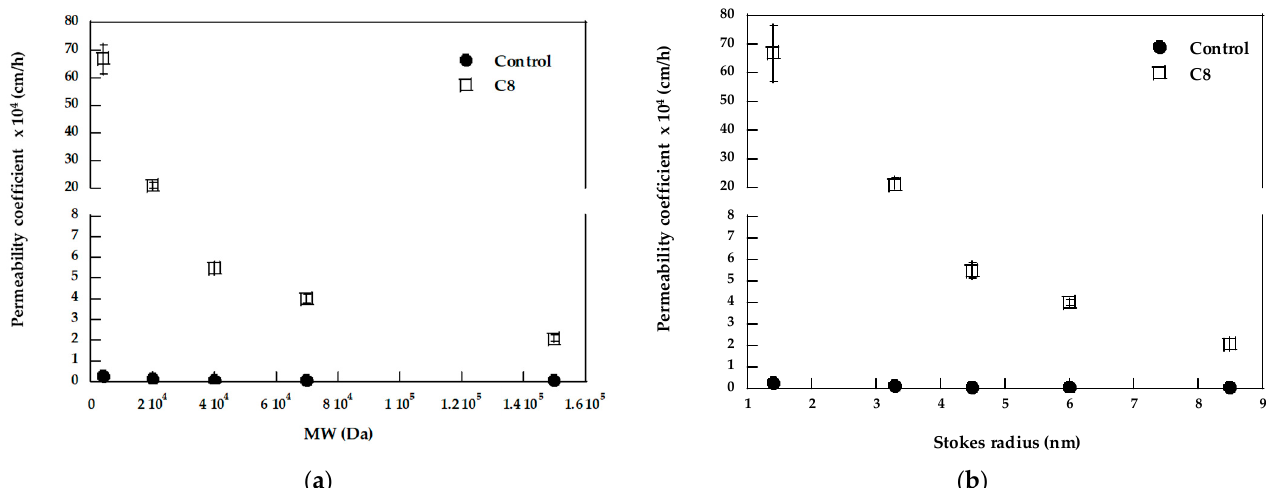
Figure 4. Permeability coefficient of dextrans as a function of molecular weight ( a ) and of Stokes radius ( b ). Stokes radius was from the Supplier (https://www.sigmaaldrich.com/deepweb/assets/sigmaaldrich/product/documents/425/562/fd70pis.pdf, accessed on 15 October 2022). Mean values ± SEM.